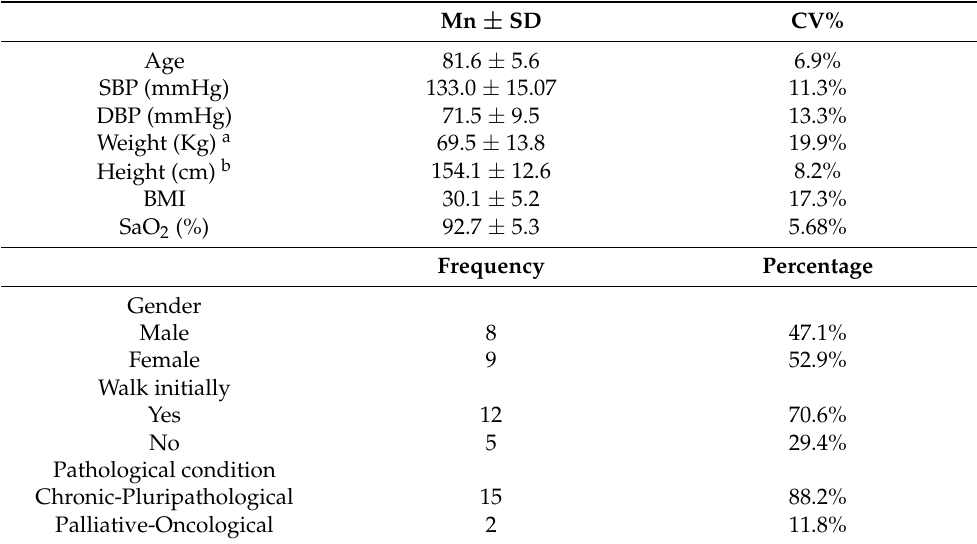
Table 1. Descriptives ( n = 17): mean, standard deviation, coefficient of variation, and frequencies.